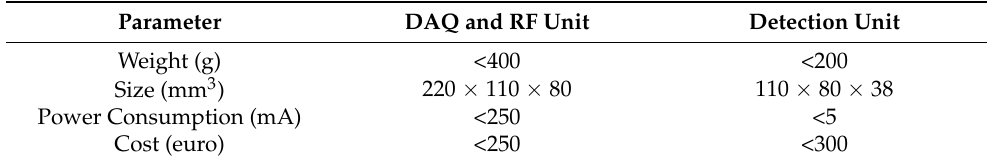
Table 1. Characteristics of the assembled